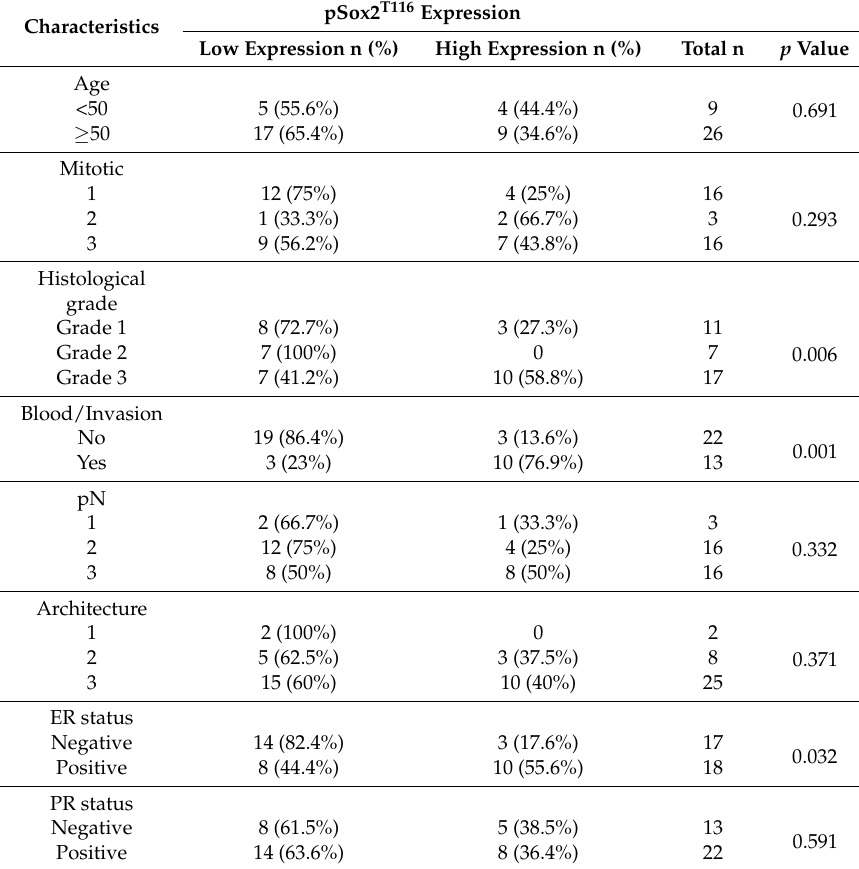
Table 1. Correlation between pSox2T116 expression and clinicopathological features in breast